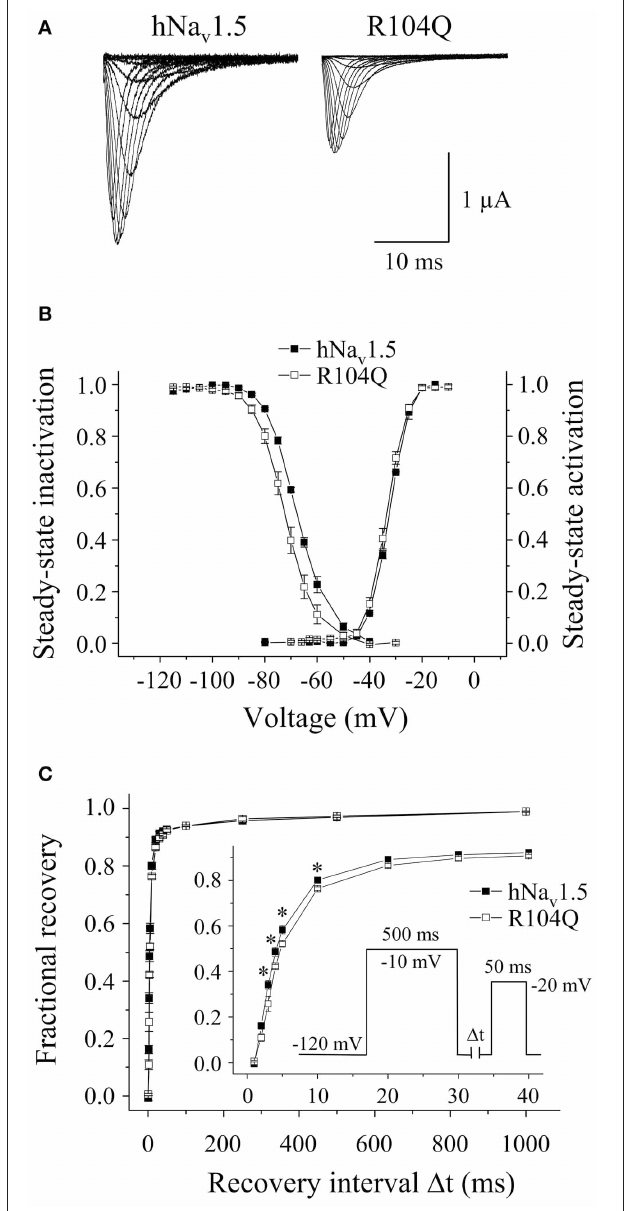
FIGURE 6 | Electrophysiological properties of R104Q in Xenopus oocytes. (A) Whole-cell Na + currents. Peak current amplitudes were significantly reduced in R104Q (see Table 1 ). Currents were elicited from − 80mV to various test pulses in 5 or 10mV increments at a pulsing frequency of 1.0Hz (holding potential − 120mV). (B) Steady-state activation and inactivation curves. In R104Q, steady-state availability was significantly reduced. (C) Recovery from inactivation was slower in R104Q ( ∗ indicates p < 0 . 05 vs. hNa v 1.5). For individual values see Table 3